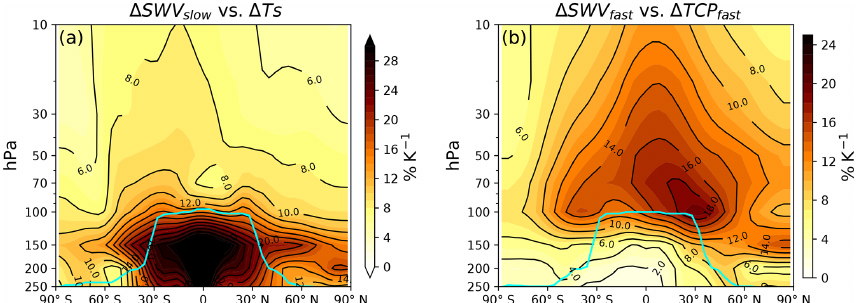
Figure 4. (a) Multi-model and multi-perturbation mean slope (%K − 1 ) from the regression between annual mean time series of (cid:49) SWV slow (at each latitude grid point and pressure level) and annual mean time series of global average (cid:49)T s . (b) Slope (%K − 1 ) from the regression between (cid:49) SWV fast (ppmv) (at each latitude grid point and pressure level) and (cid:49) TCP fast (K). The solid cyan line is the multi-model mean lapse rate tropopause derived from the baseline simulations.